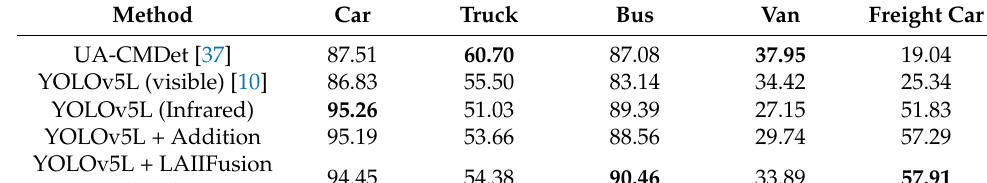
Table 2. Per-class comparisons of detection performance on the DroneVehicle dataset.